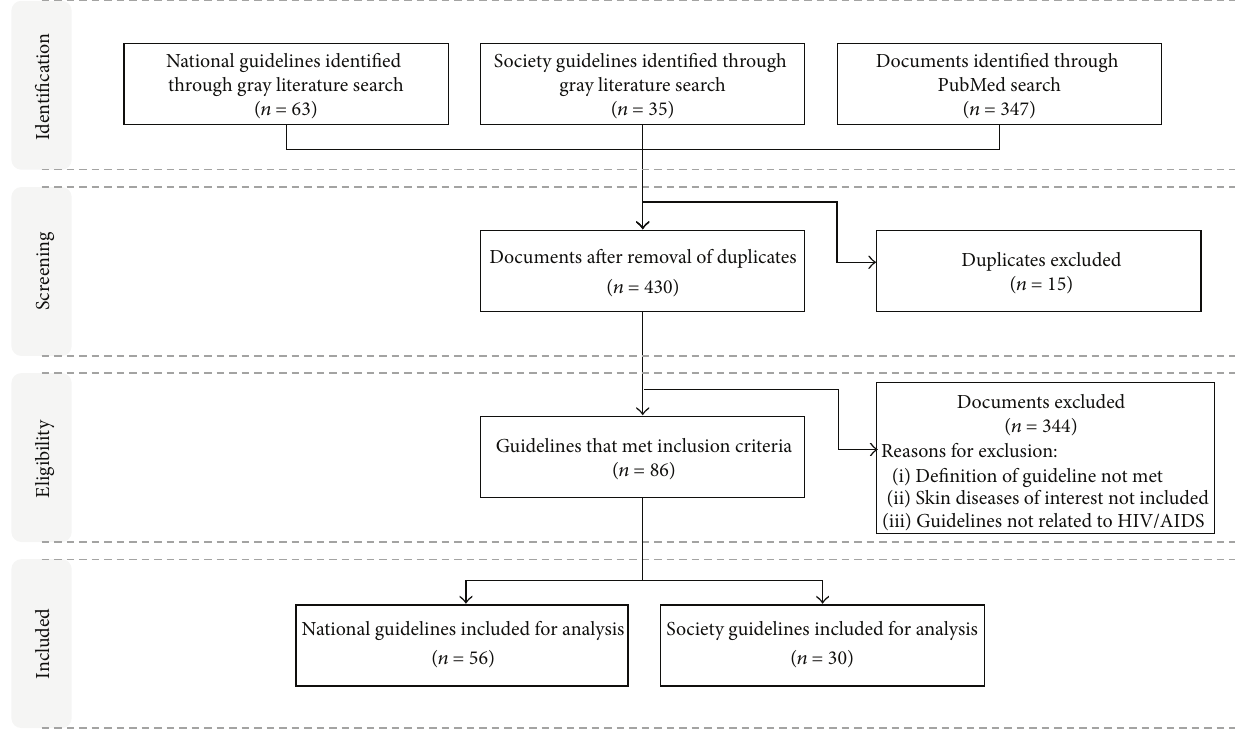
Figure 1: Prisma diagram showing selection process of treatment guidelines for HIV-related skin